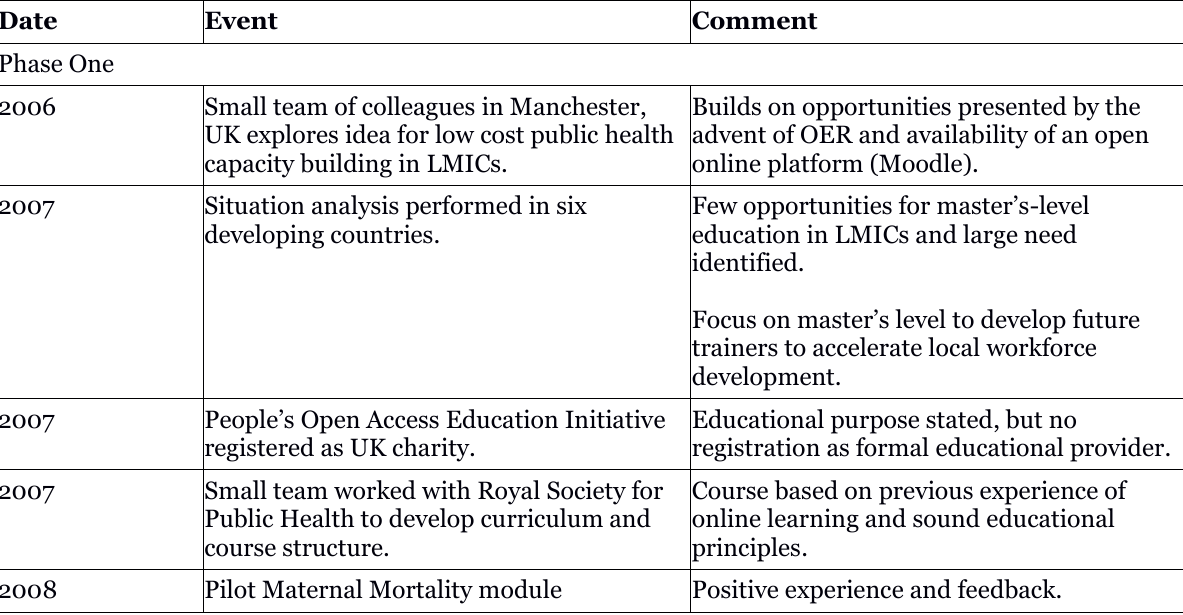
Timeline of Key Steps in Development of